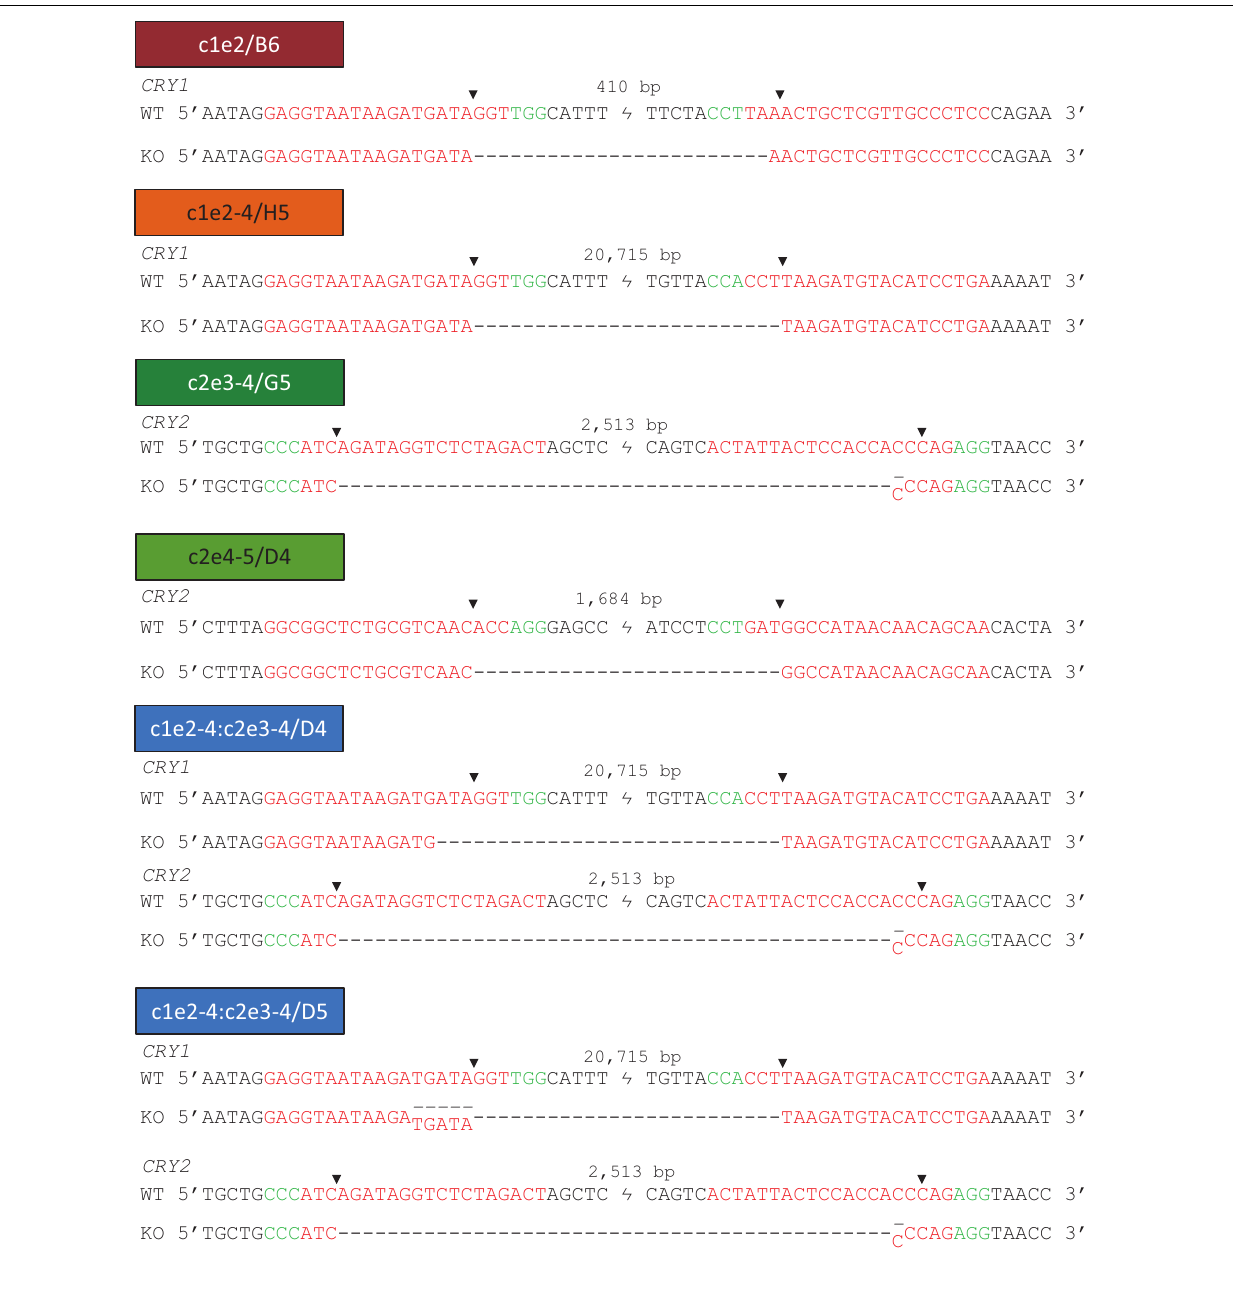
FIGURE 3 | Sequences of single cell clone genomic regions confirm deletion of targeted exons. Out-out-PCR products for each KO clone (see marked bands in Supplementary Figure 2B ) were gel-purified, sequenced and aligned to corresponding wild-type sequence. SgRNA recognition sequences are indicated in red, PAM sequence in green and expected Cas9 cutting site by an arrow. Sequence ambiguities suggest that genome editing was not identical for the two